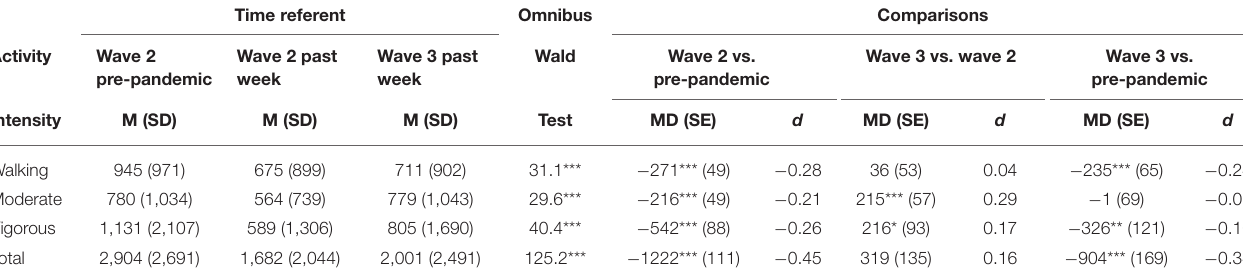
TABLE 2 | Mean MET-min/week of physical activity by intensity-level and referent time period. Time referent Omnibus Comparisons Activity Wave 2 Wave 2 past Wave 3 past Wald Wave 2 vs. Wave 3 vs. wave 2 Wave 3 vs. pre-pandemic week week pre-pandemic